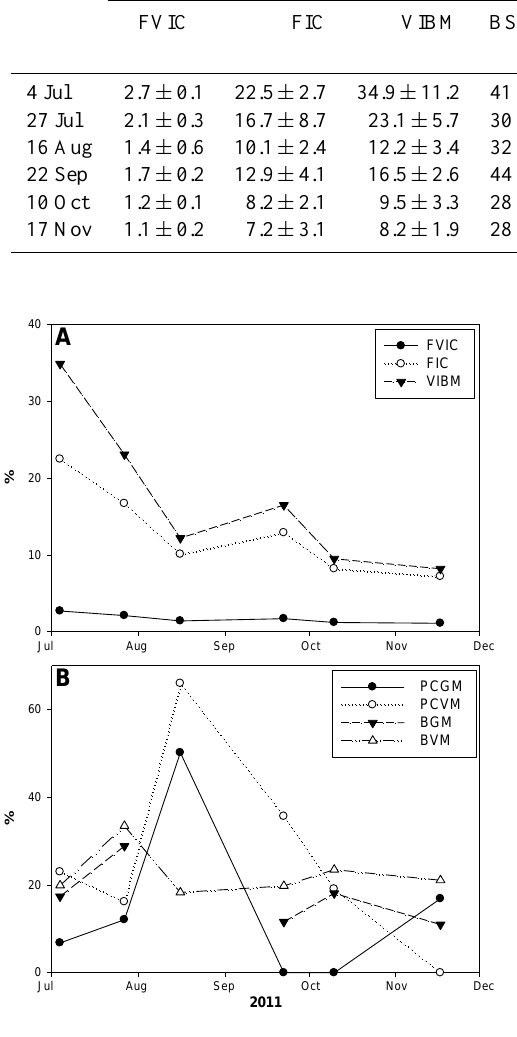
Fig. 3. Patterns of the frequency of virus-infected bacterial cells (FVIC), the frequency of infected bacterial cells (FIC) as estimated using transmission electron microscopy and the virus-induced bac- terial mortality (VIBM) (A) . Grazing mortality and viral lysis on picocyanobacteria (PCGM and PCVM, respectively) and on het- erotrophic bacteria (BGM and BVM) estimated using the modified dilution technique (B) .